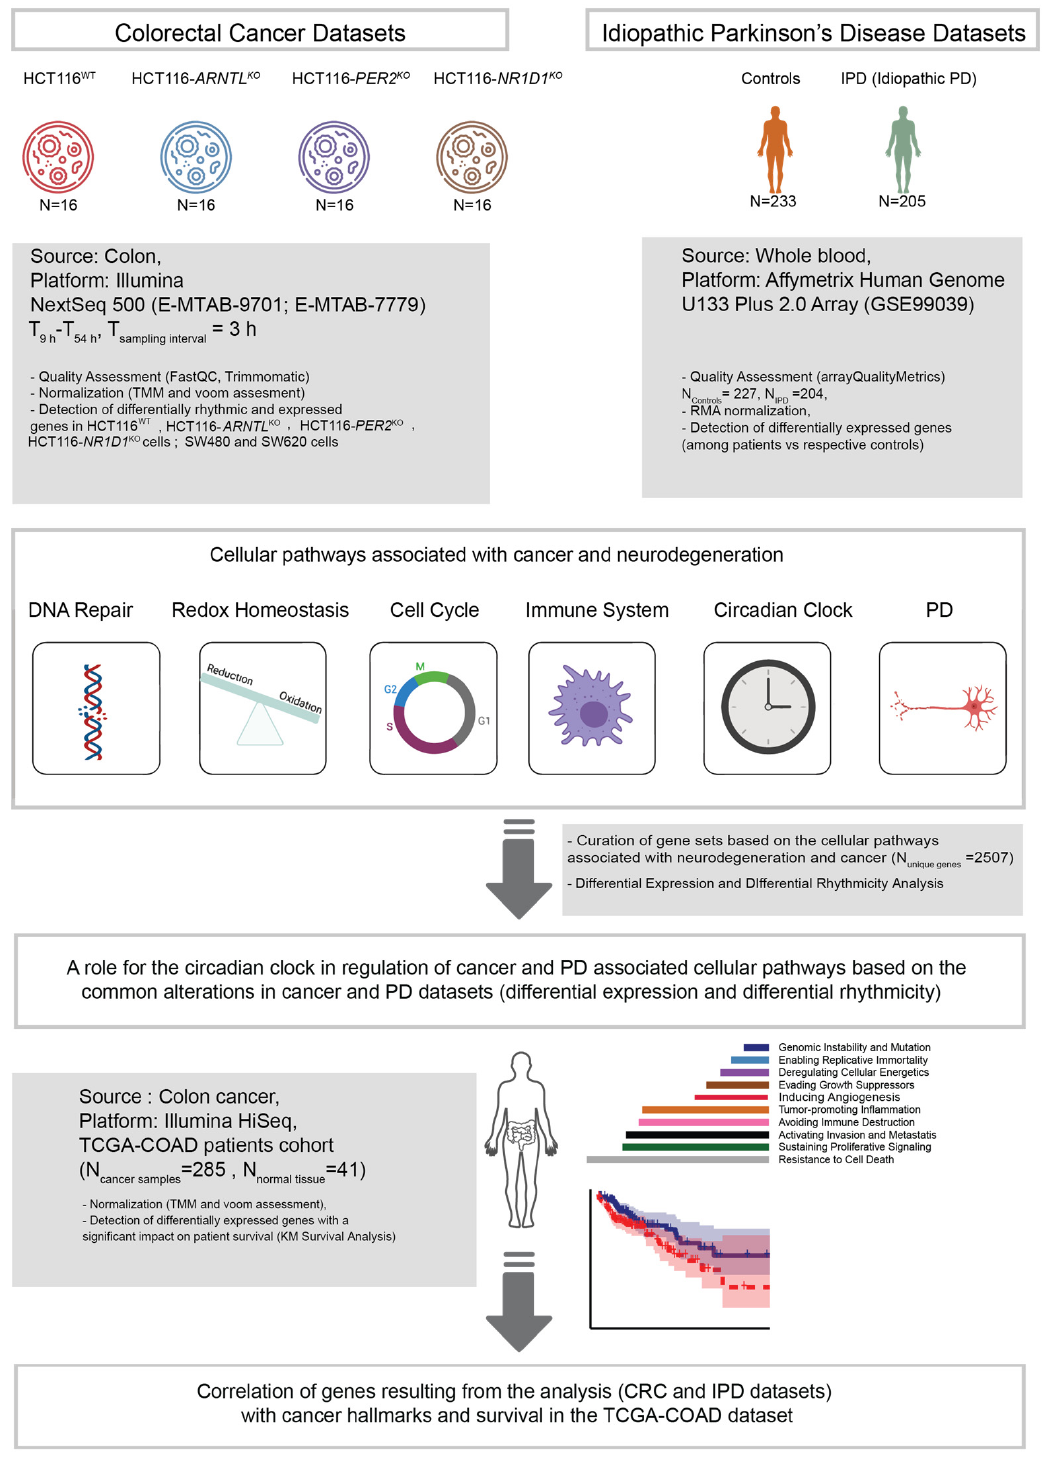
Figure 1. Workflow for the analysis of time-series RNA-seq data sets from CRC cell lines and microarray data sets from a cohort of IPD patients. KO cells were derived from HCT116 WT cells using CRISPR/Cas9 methodology. RNA-seq data sets (ArrayExpress: E-MTAB-9701) include the HCT116 WT and three core-clock knockout cells (HCT116- ARNTL KO , HCT116- PER2 KO and HCT116- NR1D1 KO ) sampled as indicated. Data sets of two additional CRC cell lines (SW480, SW620; ArrayExpress: E-MTAB-7779) were also included in the rhythmicity analysis as indicated. Following data pre-processing, circadian and ultradian rhythms were detected and differential rhythmicity analysis was performed. In addition, differential gene expression analysis was carried out for all expressed genes as compared to the corresponding controls, for HCT116 cells and IPD data sets (GEO: